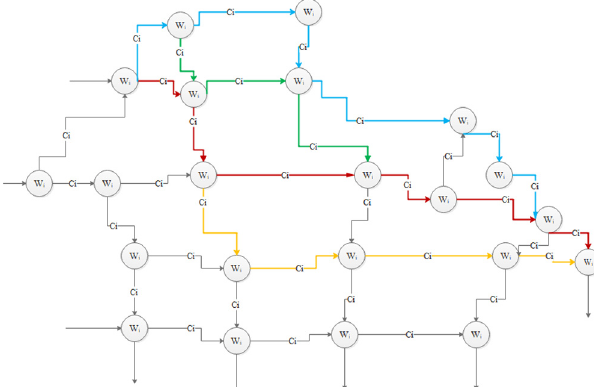
Figure 8. Adviser path